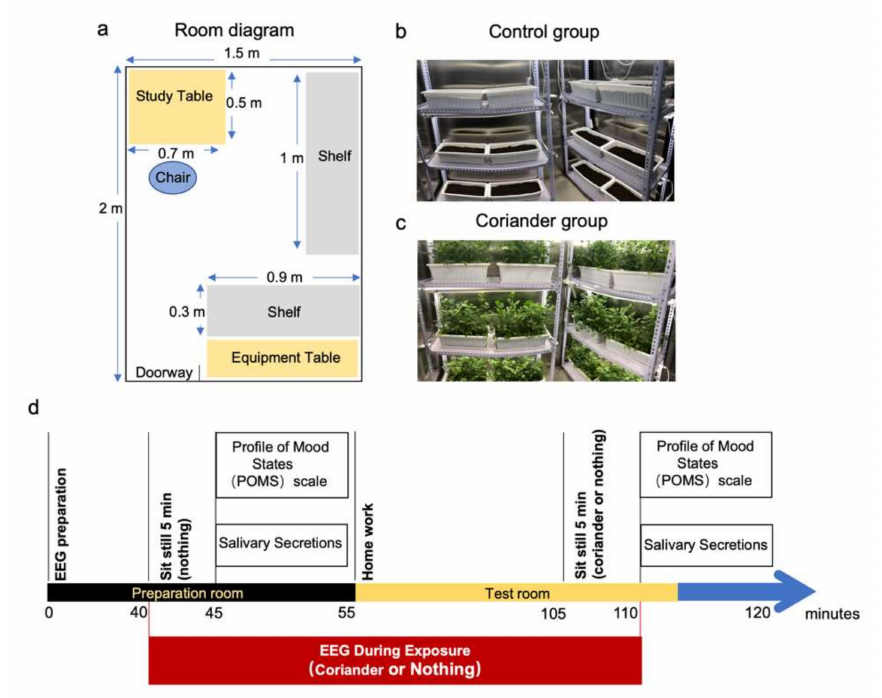
Figure 1. ( a ) The yellow parts indicate the location of the study table and the equipment table. The study table is used for participants to do homework. The equipment table is used to place EEG equipment. The gray parts indicate the position of the coriander shelves (three layers). The blue ellipse shows the position of participants. ( b ) Real scene of the control group. ( c ) Real scene of the coriander group. ( d ) Overview of the protocol design. The blue arrow indicates the total test time. After explaining the test details and protocol, EEG equipment was prepared for 40 min in the preparation room. The participants sat still for 5 min. Subsequently, the participants answered the POMS questionnaire, and the first saliva sample was collected for 10 min. Then the participants entered the test room with or without coriander to do homework for 50 min. After that, the two groups of participants were asked to watch coriander or shelves and sit still for 5 min. Finally, the participants answered the POMS questionnaire and collected the second saliva